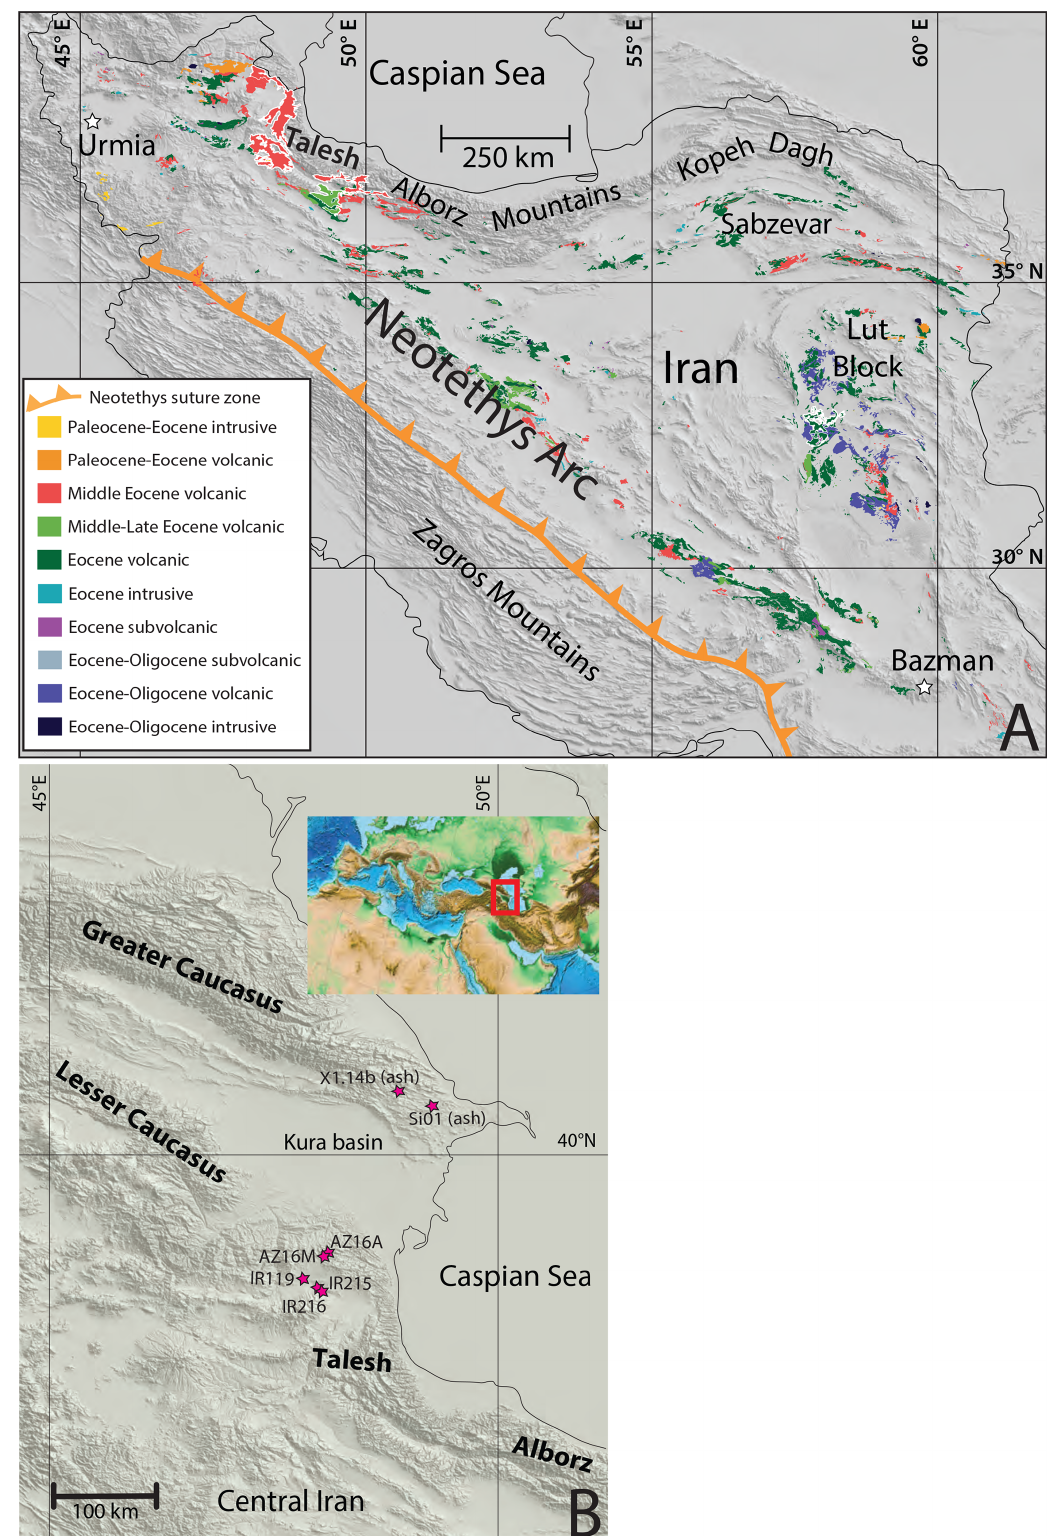
Figure 1. (a) Map showing the outcrop of Eocene volcanic rocks in Iran (modified after Agard et al., 2011, and shapefiles of Sahandi et al., 2014). The five largest areas are shown with white outlines. (b) Sample locations of newly acquired 40 Ar / 39 Ar